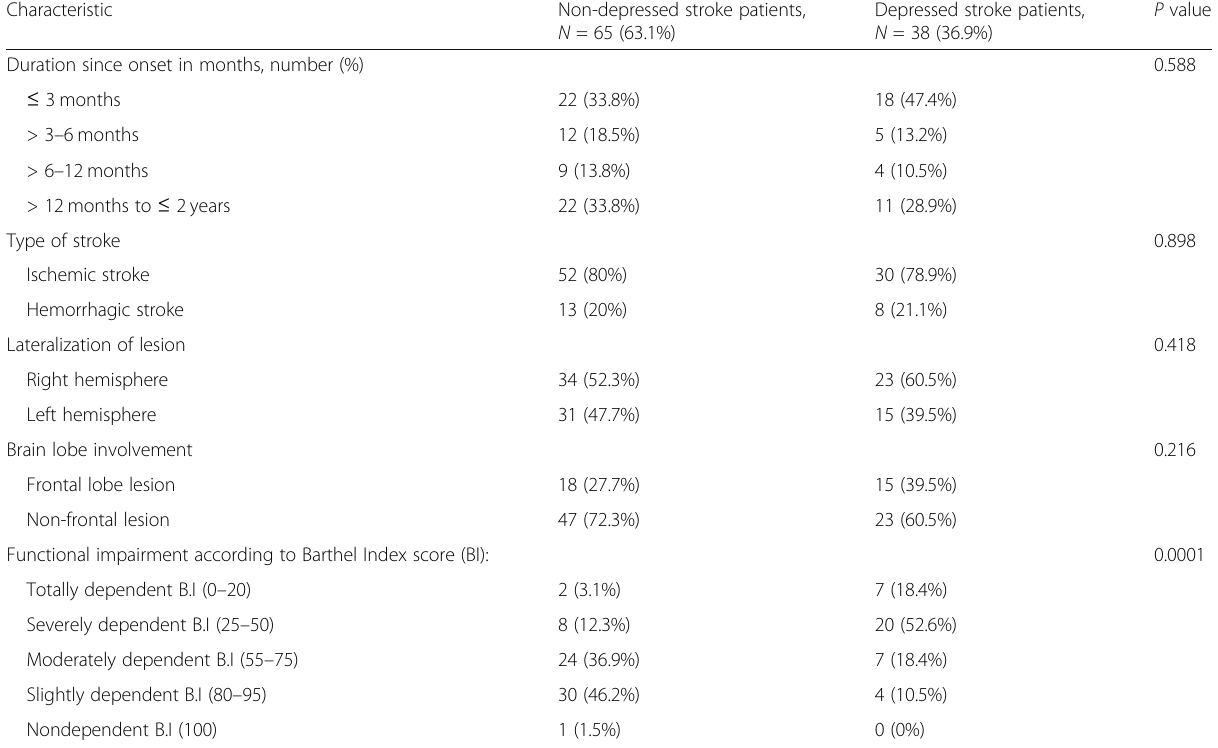
Table 4 Stroke indices and post-stroke depression Characteristic Non-depressed stroke patients,